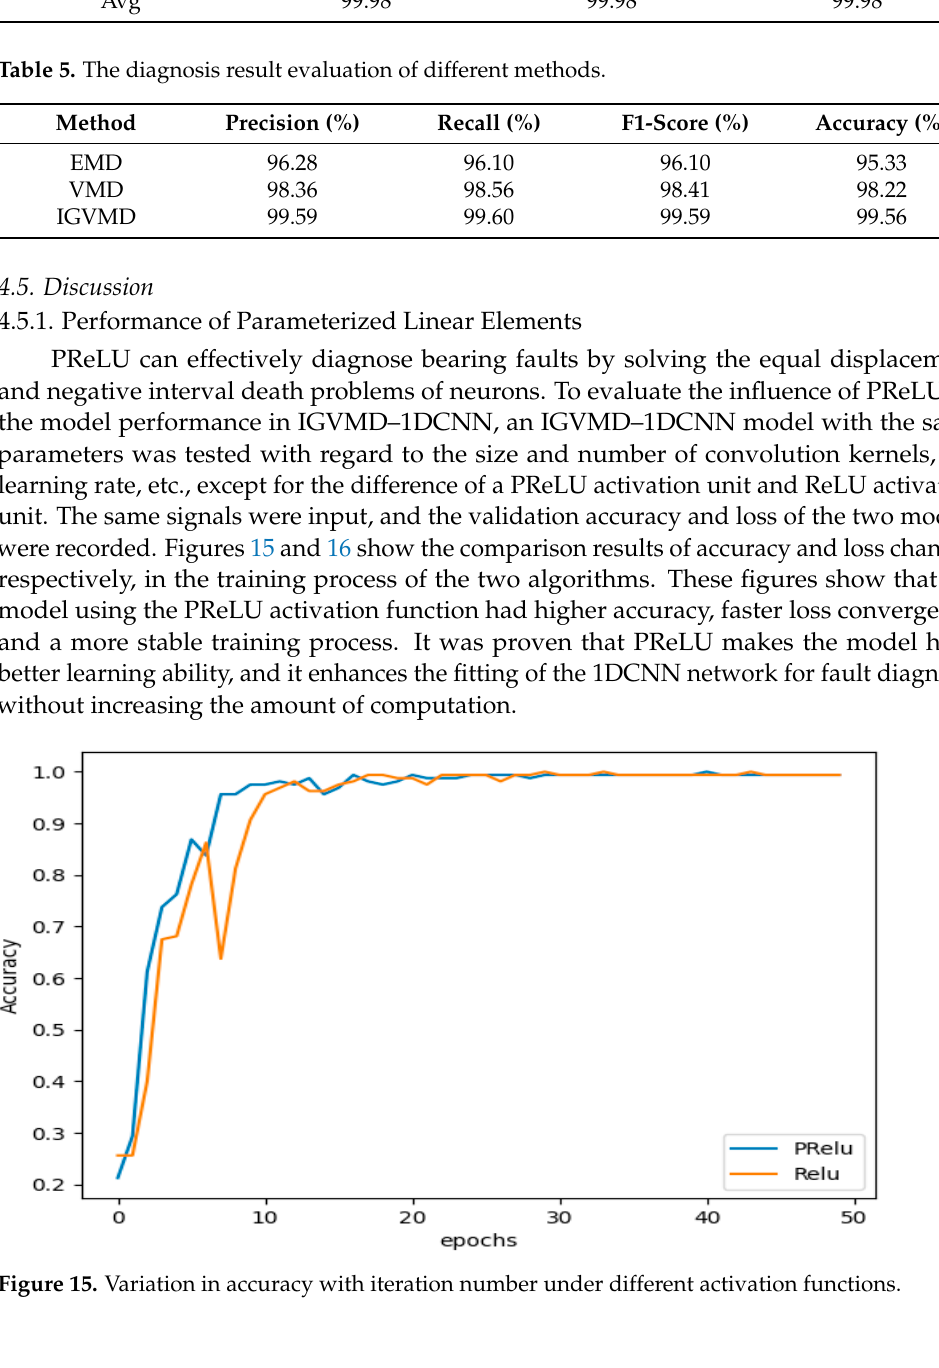
Figure 16. Variation in loss with iteration number under different activation functions. 4.5.2. Influence of Data Preprocessing on the Model The IGVMD method can eliminate the influence of background noise on the model through decomposition of the original signal and screening of effective information. A group of comparison tests was set, the same data and parameter settings were input, and the number of iterations to was set to 50. The IGVMD–1DCNN and 1DCNN models were compared, and the accuracy and loss of the two models on the validation set were rec- orded. The accuracy rate and loss changes of the two algorithms in the training process are shown in Figures 17 and 18, respectively.